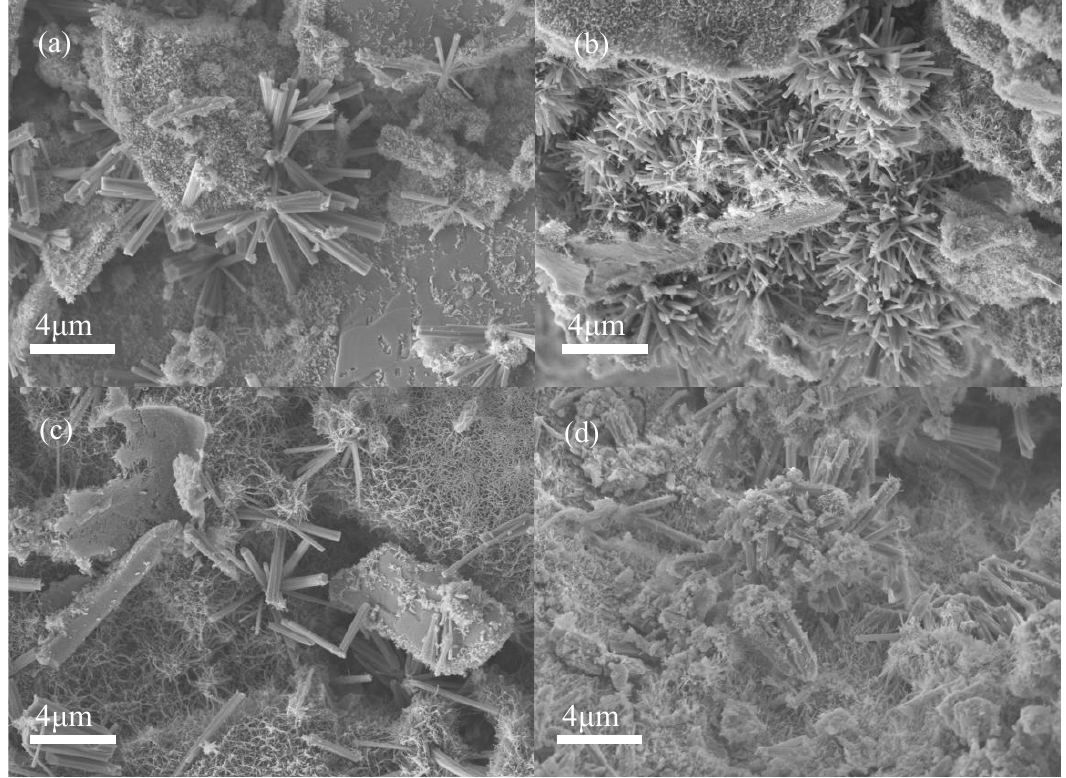
Figure 11. SEM images of backfill samples: ( a ) PB cured for 7 d with ITs; ( b ) PBI-20 cured for 7 d; ( c ) PB cured for 28 d; ( d ) PBI-20 cured for 28 d.